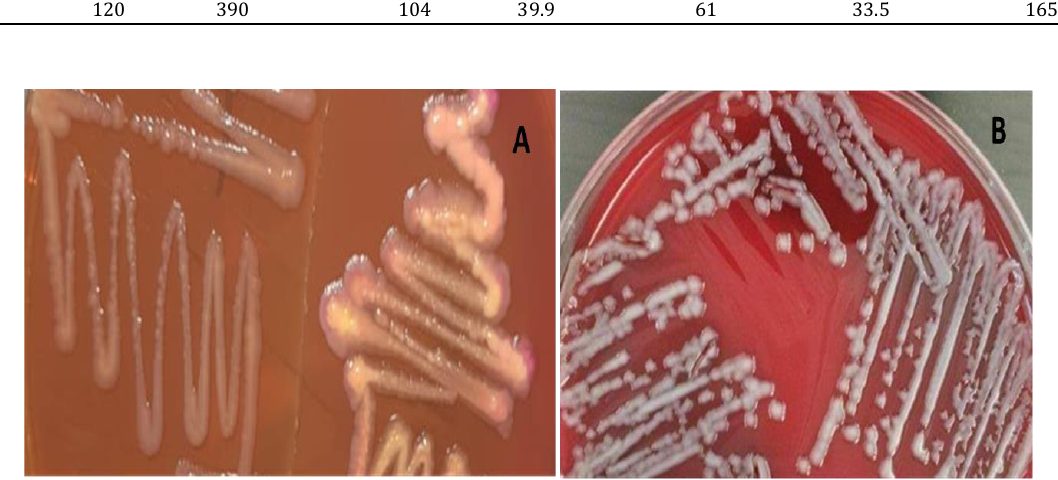
Figure 1. Staphylococcus species growth on A: Mannitol salt agar and B: Blood agar